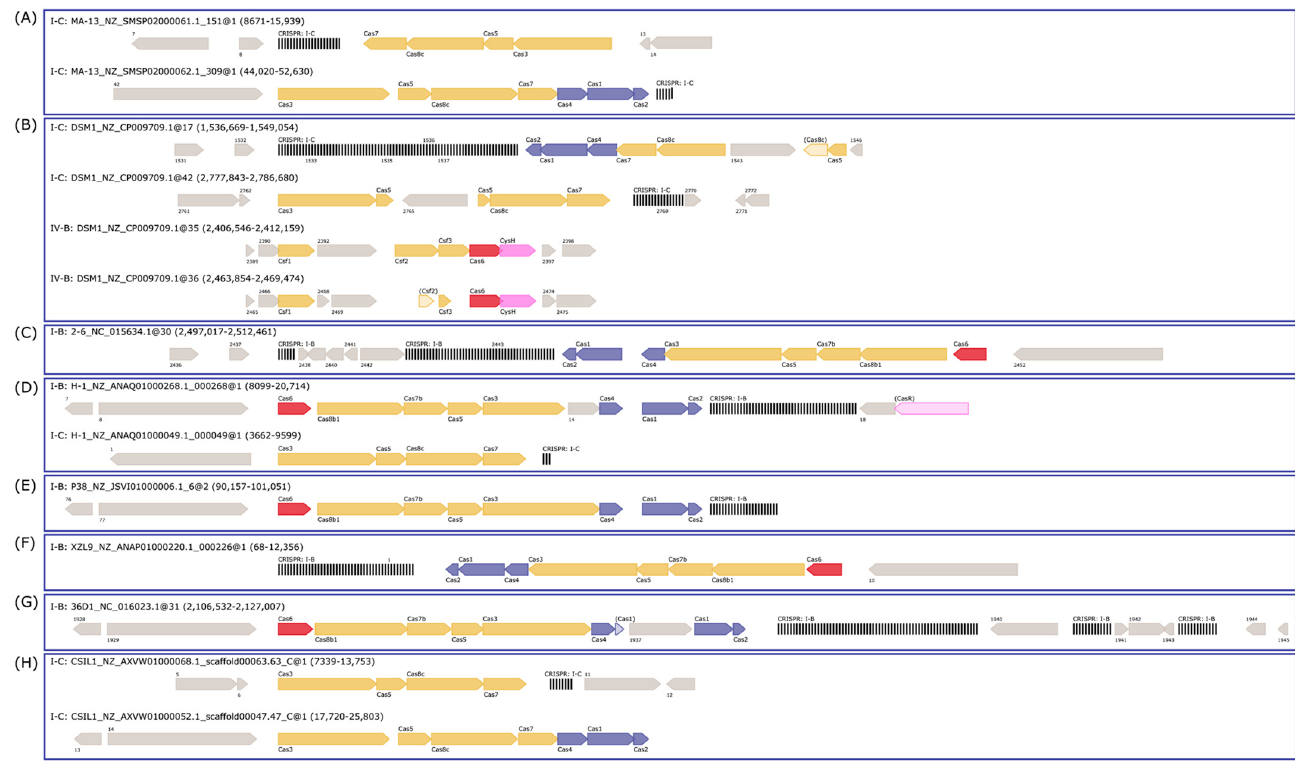
Figure 8. CRISPR-Cas cassettes present in W. coagulans genomes. The cas operons for each strain are depicted: ( A ) MA-13, ( B ) DSM1, ( C ) 2–6, ( D ) H-1, ( E ) P38, ( F ) XZL9, ( G ) 36D1, and ( H ) CSIL1. The headers above each operon refer to the type of cas operon, strain, contig, and location. The color of cas genes corresponds to their associated stage of the CRISPR-Cas response: blue—adaptation; yellow— interference; and red—crRNA maturation. CRISPR arrays are depicted as black, vertical